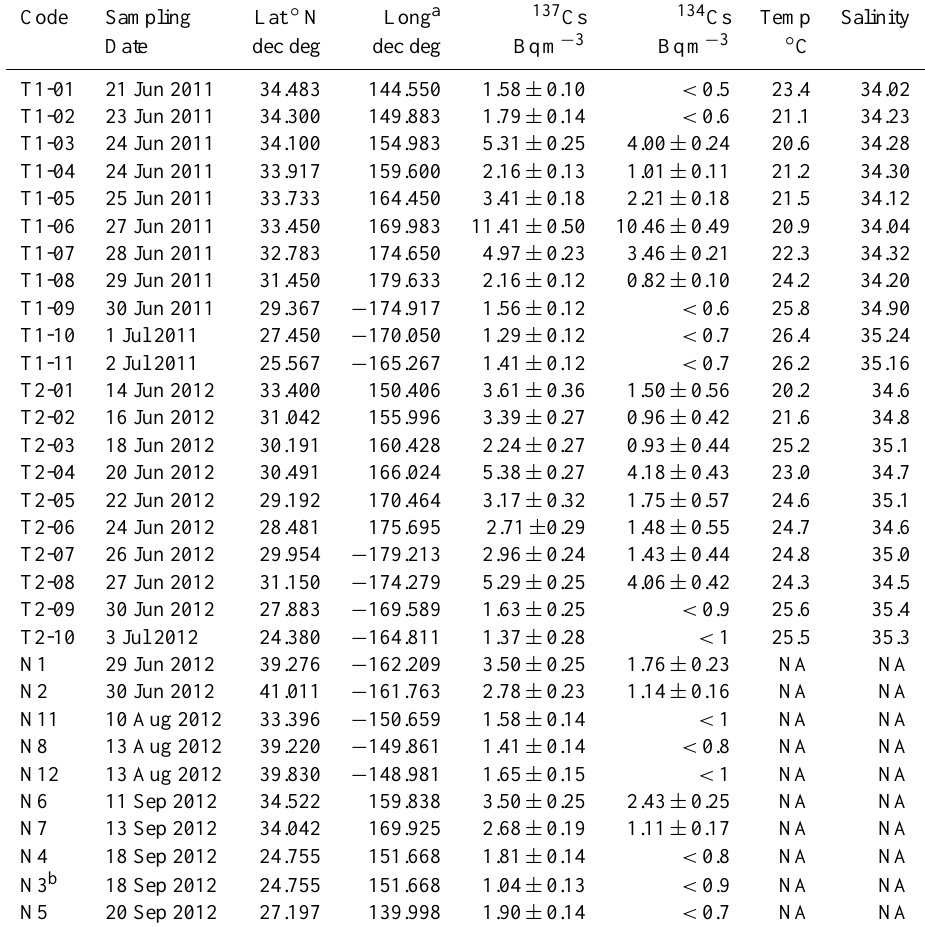
Table 2. Activities of 134 Cs and 137 Cs in seawater between Japan and Hawaii after the Fukushima Dai-ichi Nuclear Power Plant accident. All samples were collected from the surface except N3. Activities are decay-corrected to 11 March